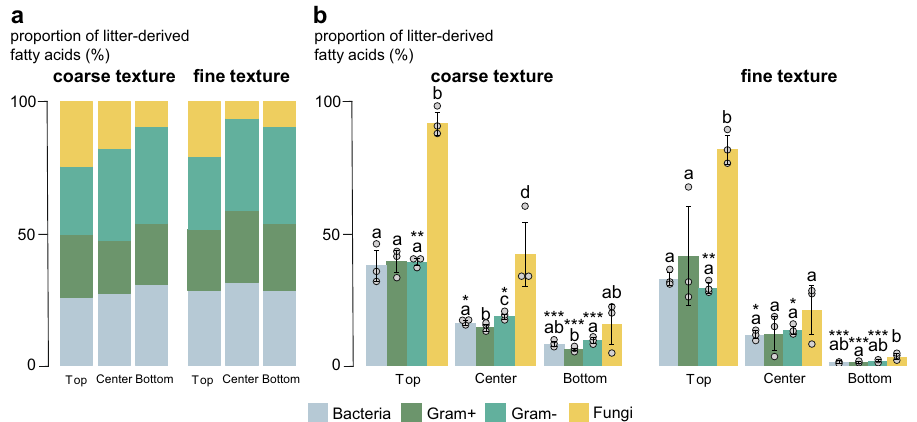
Fig. 5 Litter incorporation in microbial biomass. a The proportion of litter-derived fatty acids within a certain microbial group related to the total amount of litter-enriched fatty acids in the entire sample (%) in the three depths of two textures (means, n = 3 independent replicates). b The proportion of 13 C-enriched fatty acids compared to unlabeled fatty acids within each microbial group (%) in the three depths of two textures (means, SDs displayed with errors bars, n = 3 independent replicates). Lowercase letters represent signi fi cant differences ( P < 0.05) between microbial groups and asterisks (* P < 0.05, ** P < 0.01, *** P < 0.001) represent differences between textures. Statistical signi fi cance between texture was analyzed using an unpaired two-sided t -test and differences between microbial groups with the Kruskal-Wallis test. Differences between depths were signi fi cant in all groups ( P < 0.05; one-way ANOVA with Tukey ’ s HSD).